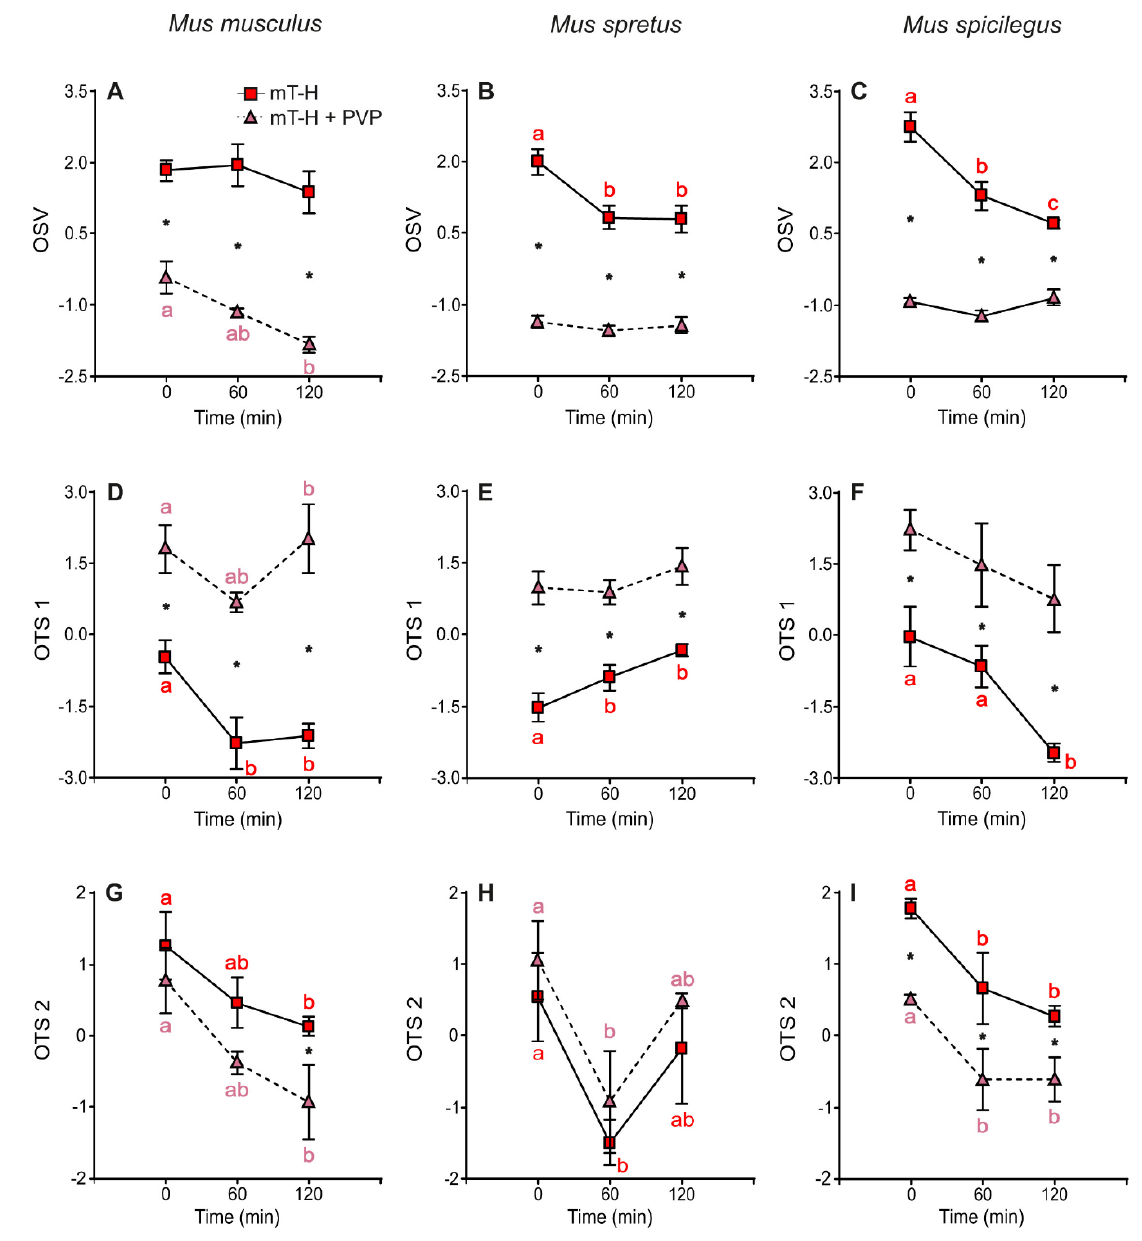
Figure 3. Variation in the principal components of swimming: OSV, OTS 1, and OTS 2 over time in sperm incubated in non-capacitating conditions in low viscosity (mT − H medium under air) and high viscosity (mT − H + PVP medium under air). Data are means ± SE ( M. musculus : N = 4; M. spretus : N = 5; M. spicilegus : N = 4). ( A – C ): OSV. ( D – F ): OTS 1. ( G – I ): OTS 2. ( A , D , G ): M. musculus . ( B , E , H ): M. spretus . ( C , F , I ): M. spicilegus . Red squares and letters: non-capacitating conditions in low viscosity (mT − H). Pink triangles and letters: non-capacitating conditions in high viscosity (mT − H + PVP). Asterisks indicate significant differences between viscosity treatments for the same time point in a Fisher post-hoc test ( p < 0.05). Different letters indicate significant differences between time points for the same viscosity treatment in a Fisher post-hoc test ( p < 0.05).